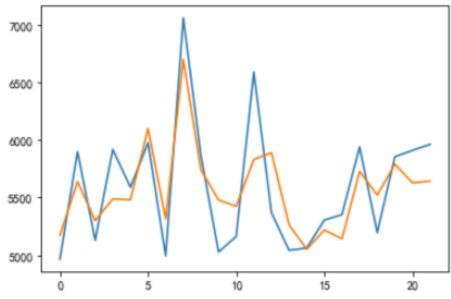
Figure 5. A319 fuel consumption forecast.